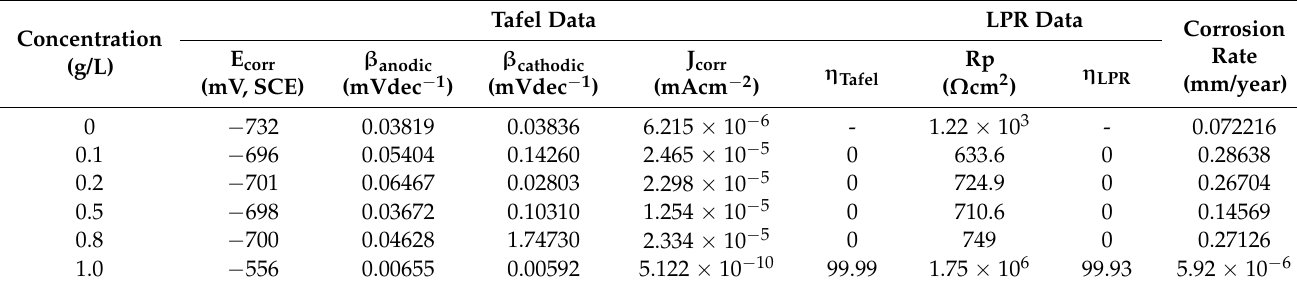
Table 4. Galvanostatic and linear polarization resistance (LPR) parameters for AISI 1020 carbon steel in neutral pH with various PA concentrations after 24 h of immersion.